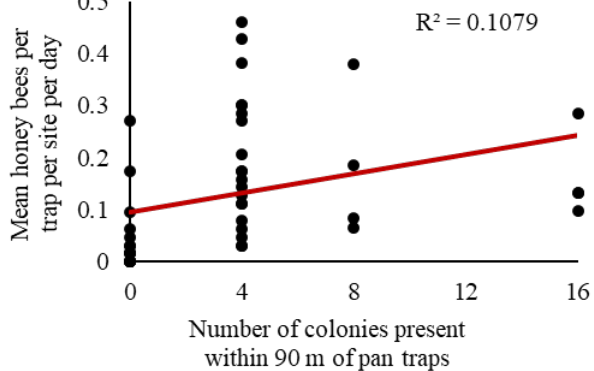
Figure 6. Correlation of colony number (0, 4, 8, or 16 colonies) with observed honey bee activity-density per trap per soybean site per day in fields in central Iowa from 2015 to 2018. Linear equation: y = 0.0092x + 0.0957.